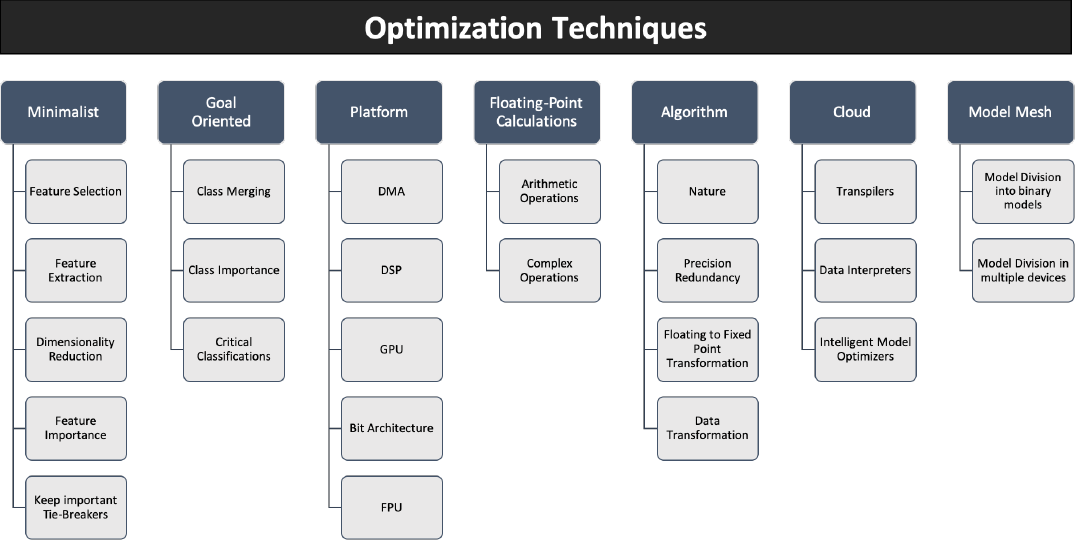
Figure 8. ML in embedded systems optimization techniques. There are multiple optimizations possible to make to reduce the size, improve performance, and make the system more reliable. The optimization can be done through: testing; minimalizing; goal-orientation; compression; development platform resources; bit architecture; floating-point calculations; environment; algorithm; cloud; and model